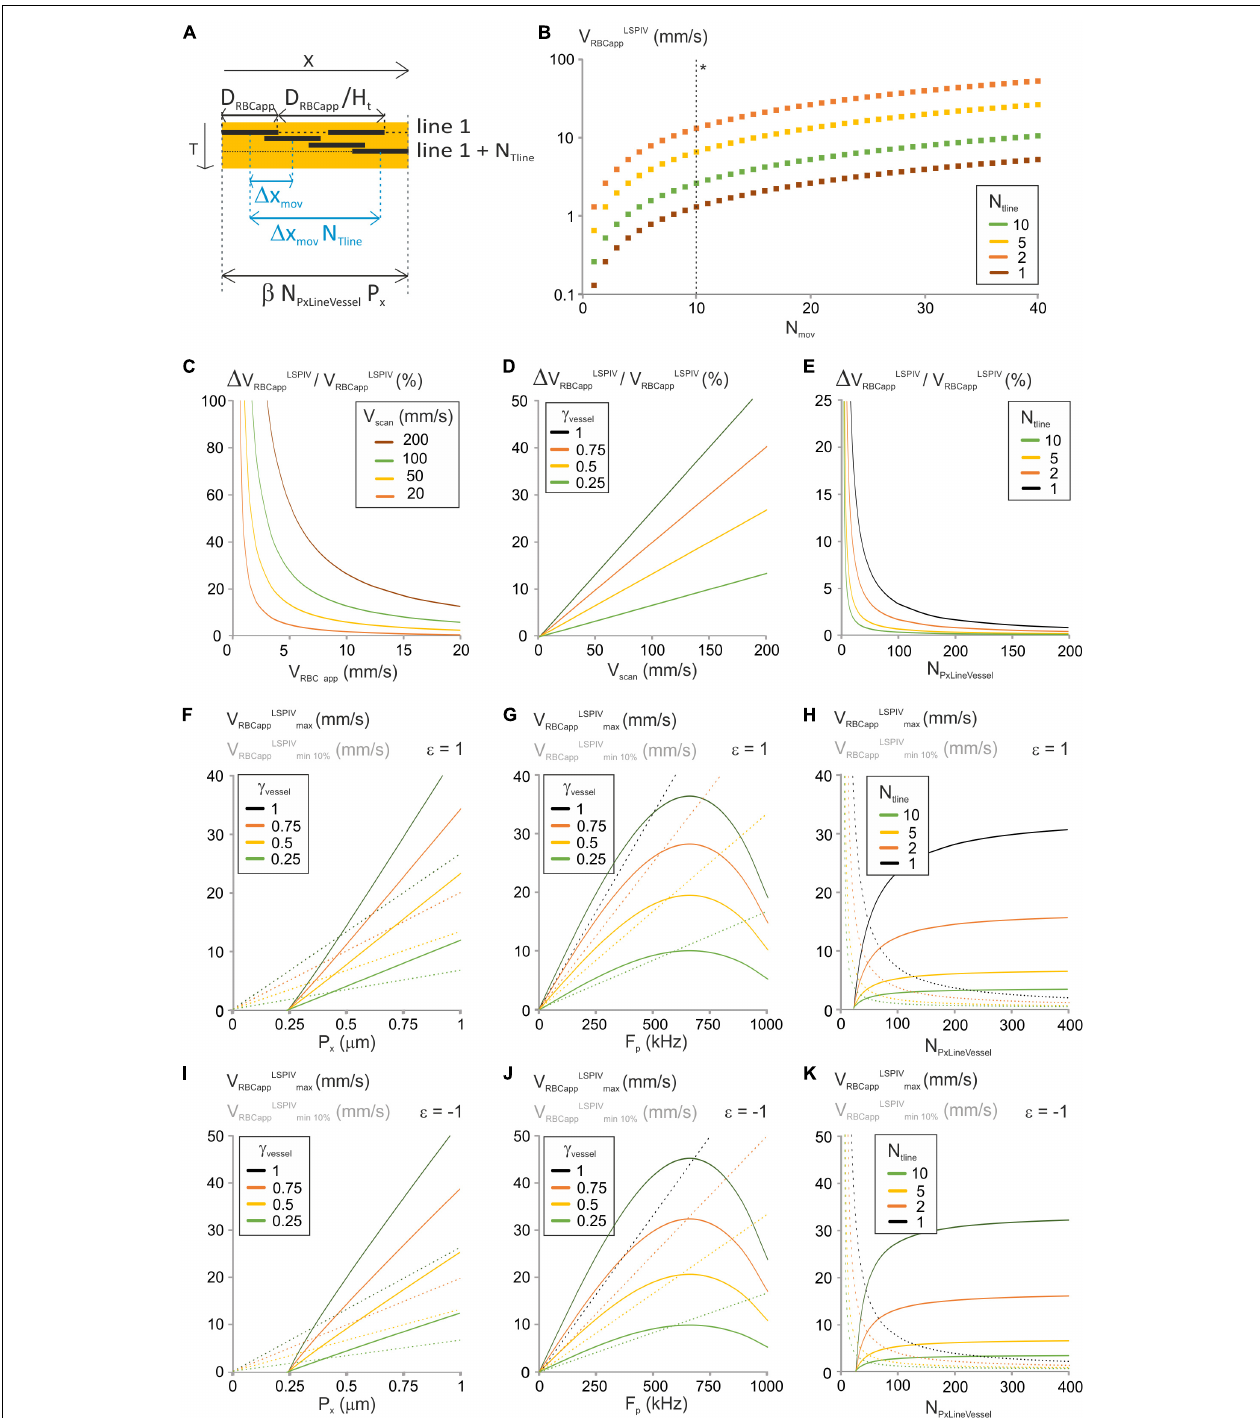
FIGURE 2 | Analysis of the “LSPIV” image-analysis method. (A) Principle of the “LSPIV” image processing algorithm and specific parameters considered in the modeling. D RBC app is the size of the shadow left by an RBC, and H t is hematocrit. (cid:49) X mov is the displacement of a RBC from one line to the successive one. Two lines from the spatiotemporal image separated by N Tline lines are selected. Their intensities are then cross-correlated and the maximum of the cross-correlogram is found, giving N Tline (cid:49) X mov . V RBC app is the ratio of (cid:49) X mov by T Line . (B) V RBCappLSPIV vs. N mov was calculated from Equation (8) for a range of N Tline with γ Vessel = 1, N PxLineVessel = 50, γ Flyback = 0.5 and V scan = 100 mm/s. (*) The dashed line gives V RBCappLSPIV . (C) (cid:49) V RBCappLSPIV /V RBCappLSPIV vs. V RBCappLSPIV was calculated from Equation (10) for a range of V scan with γ Vessel = 1, N PxLine Vessel = 50, γ Flyback = 0.5 and N Tline = 1. (D) (cid:49) V RBCappLSPIV /V RBCappLSPIV vs. V scan was